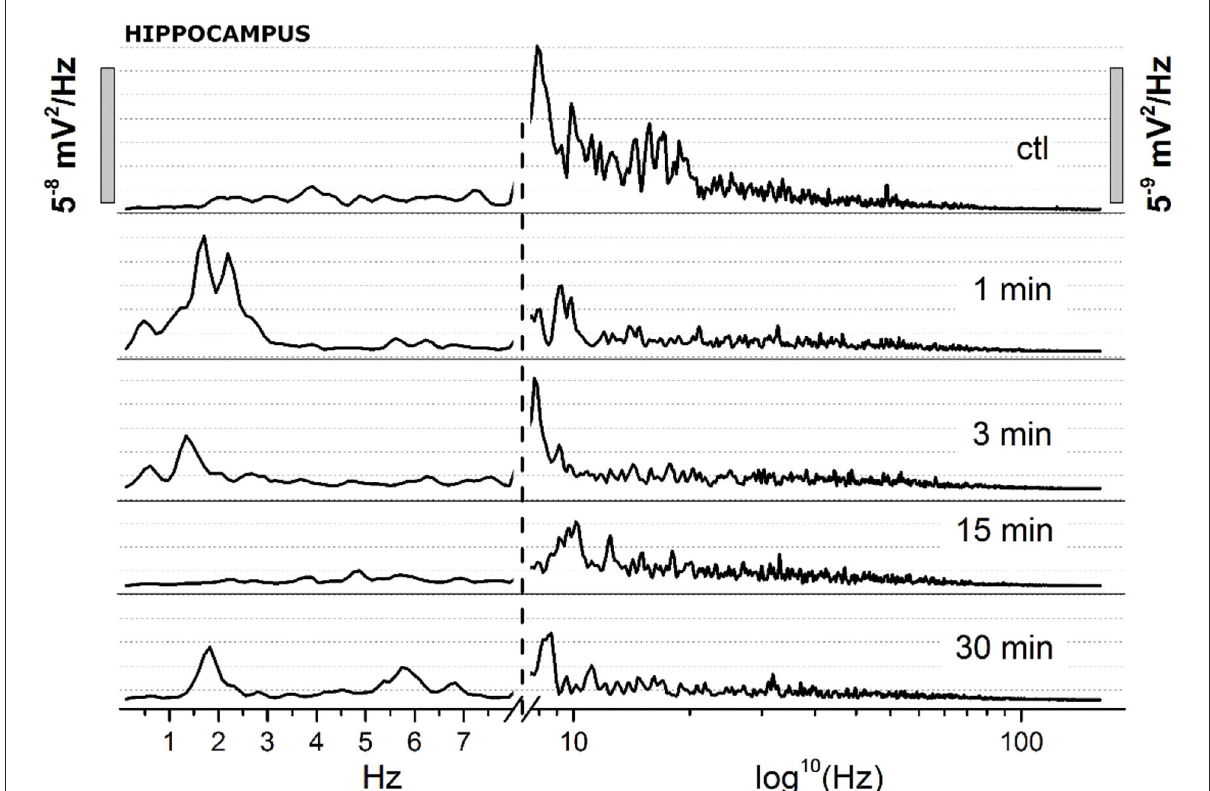
FIGURE9 Spectrum analysis (FFT) of 30s EEG segments of the figure at definite arbitrary time points (1, 3, 15, 30min). Two different Y scales (right vs. left, 1/10 ratio), has been adopted. The X axis has been broken, with linear values from 0.05 to 8Hz, and logarithmic from 8.1 to